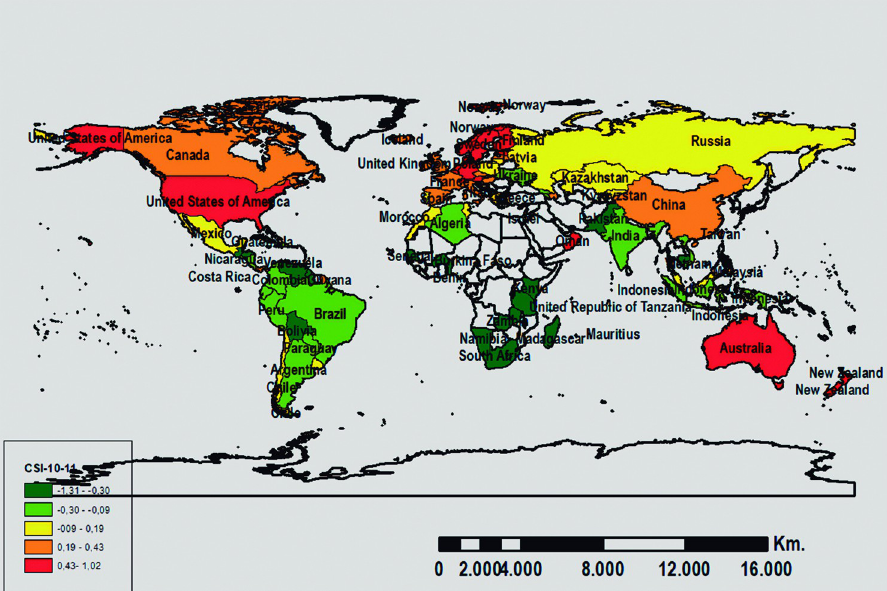
Fig 5. Geographic distribution of the CSI scores for 2010–11. Source: Prepared by authors using ArcGIS